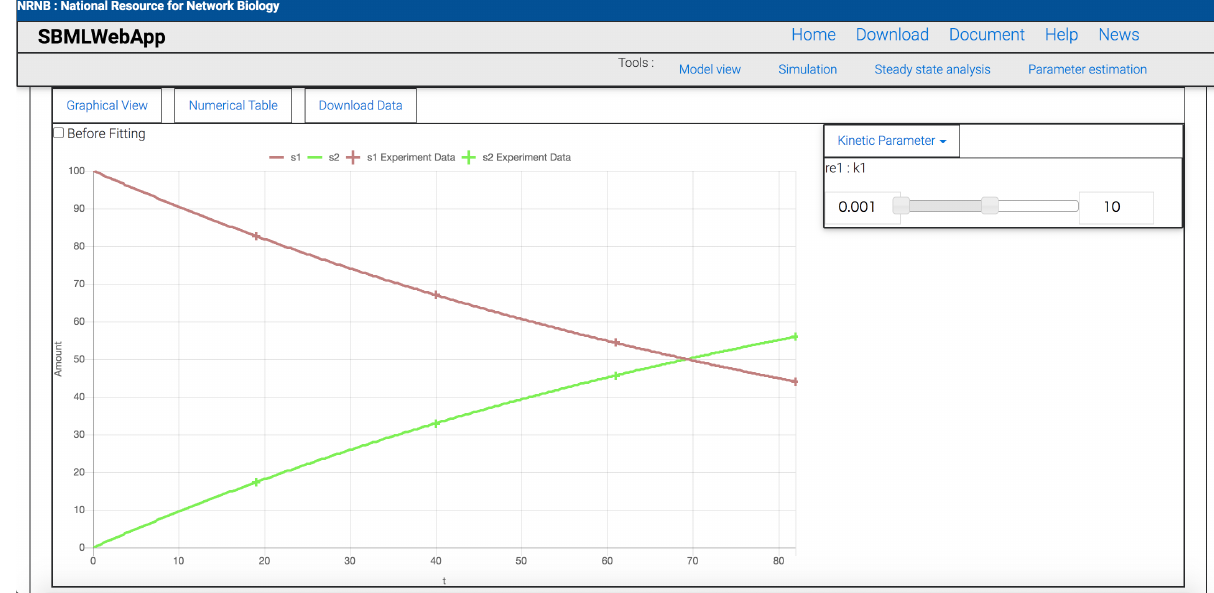
Figure 4. The result of parameter estimation. The x - and y -axis in the graph show time vs. amount or concentration in the SBML model. Each line shows the simulation result with a fitted parameter of each species. Each plot shows the experimental value of each species. The check box of “Before Fitting” can visualize the simulation result with the original parameter value. The range searching proper parameter can be set using the slider on the window’s right